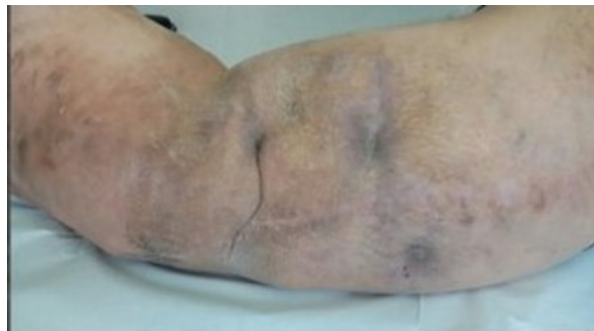
Figure 5. At 1 year after surgery, the surgical site is fully healed with no recurrence of